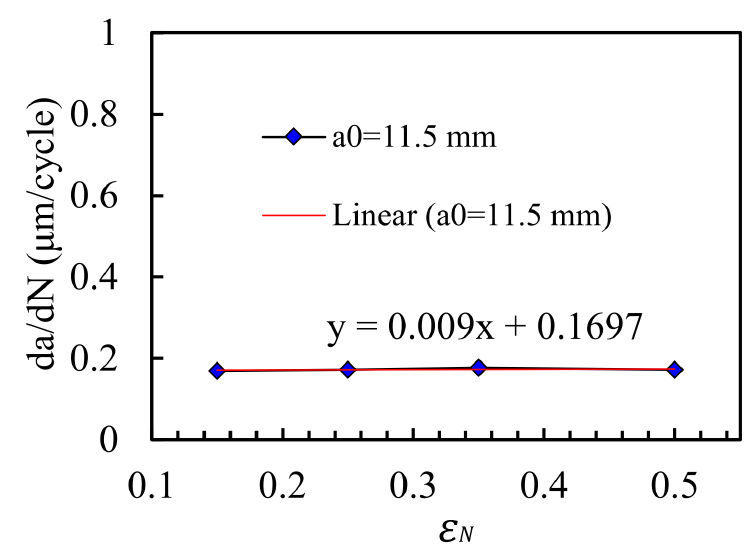
Figure 16. da/dN in terms of different values of ε N Results are presented in natural scales. Coalescence is disabled , q 1 = 1.5, q 2 = 1, q 3 = 2.25, f 0 = 0.01, f N = 0.01, and s N =